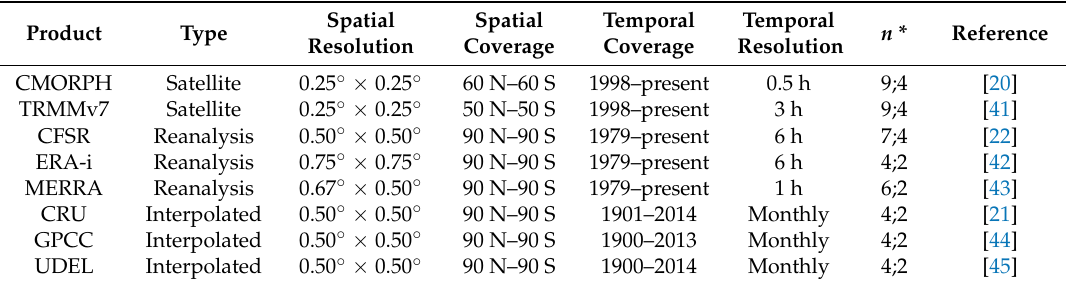
Table 1. Characteristics of the global precipitation datasets considered in this